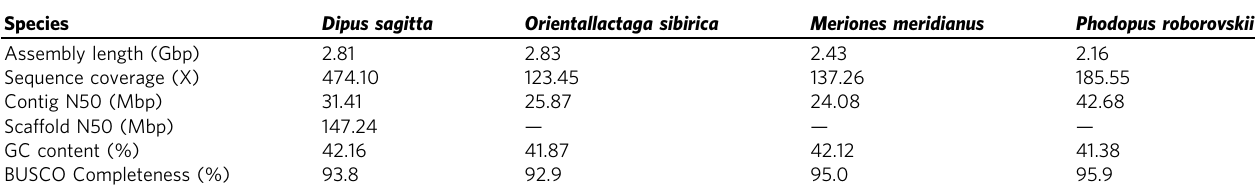
Table 1 Genome assembly statistics of the four desert